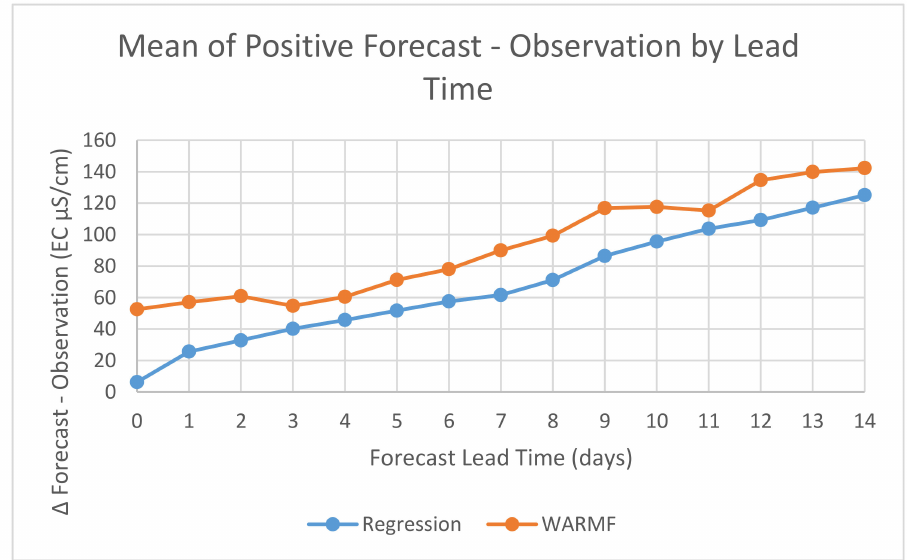
Figure 8. Comparison of means of forecasted EC and observed EC for the Regression and WARMF models for the period between 22 February 2018 and 22 May 2020. Data censored to include only over (positive) predictions.